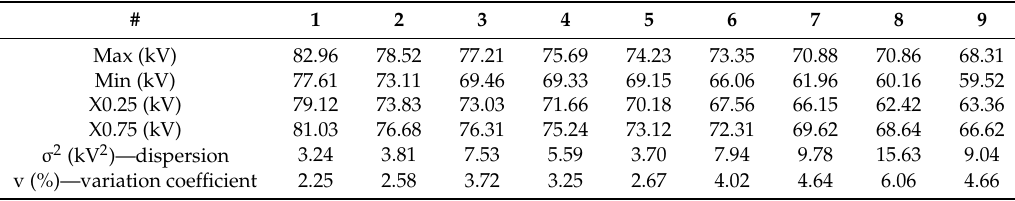
Table 8. Breakdown voltages (BDV) of the nanofluid samples.